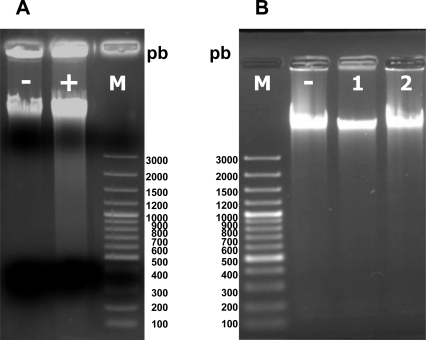
(A) Agarose gel electrophoresis of DNA extracted from MCF-7 cells incubated for 72 h in the absence (lane –) or presence of 3,3′-Diindolylmethane 50 μM (DIM, control apoptosis inducer) (lane +); (B) Agarose gel electrophoresis of DNA extracted from MCF-7 cells treated with violaxanthin. MCF-7 cells were incubated for 72 h in the absence (lane –) or presence of violaxanthin 10 μg·mL−1 (lane 1) and 40 μg·mL−1 (lane 2).